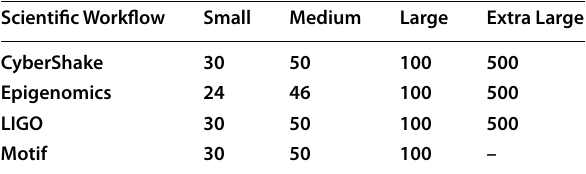
Table 2 Different sizes of workflows according to the number of